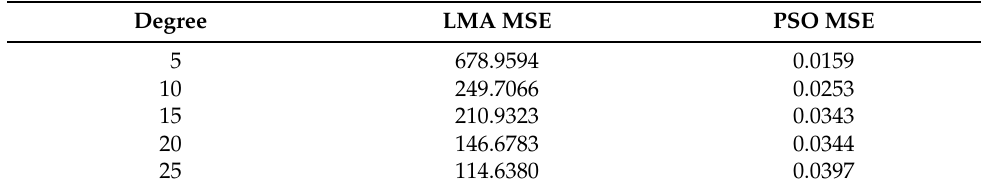
Table 5. MSE comparison for the ANN-based approach trained with LMA and PSO for polynomials with real and complex roots in polar